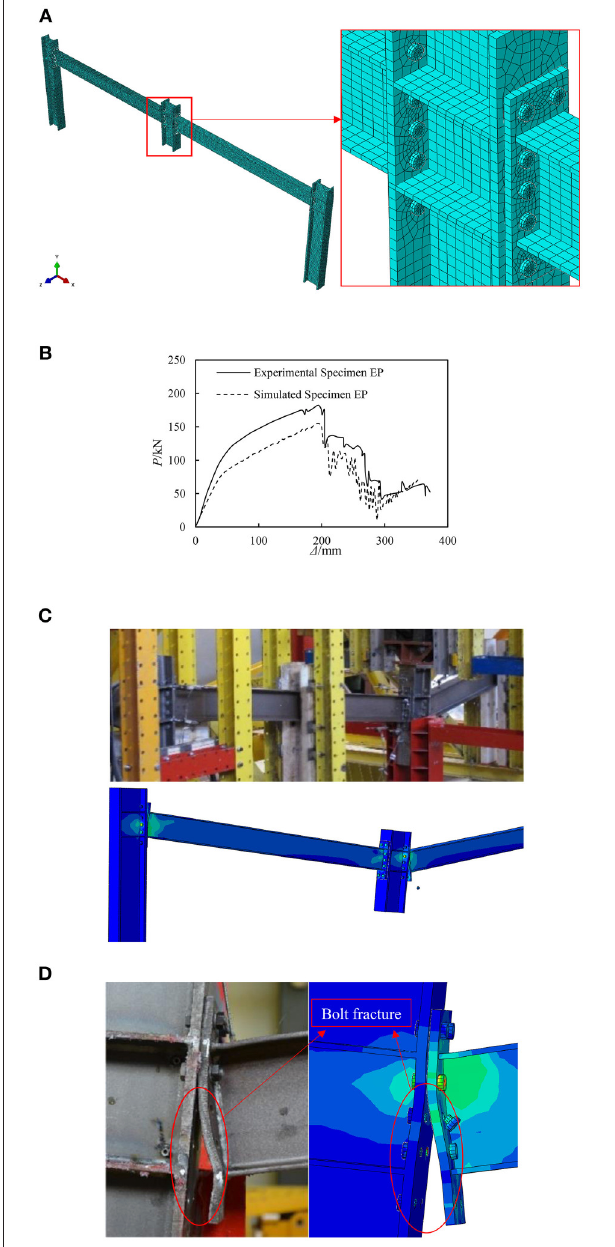
FIGURE 6 | Comparison of simulated and experimental Specimen EP. (A) FE model of Specimen EP. (B) Load-displacement at the top of middle column curve comparison. (C) Overall deformation comparison. (D) Failure mode